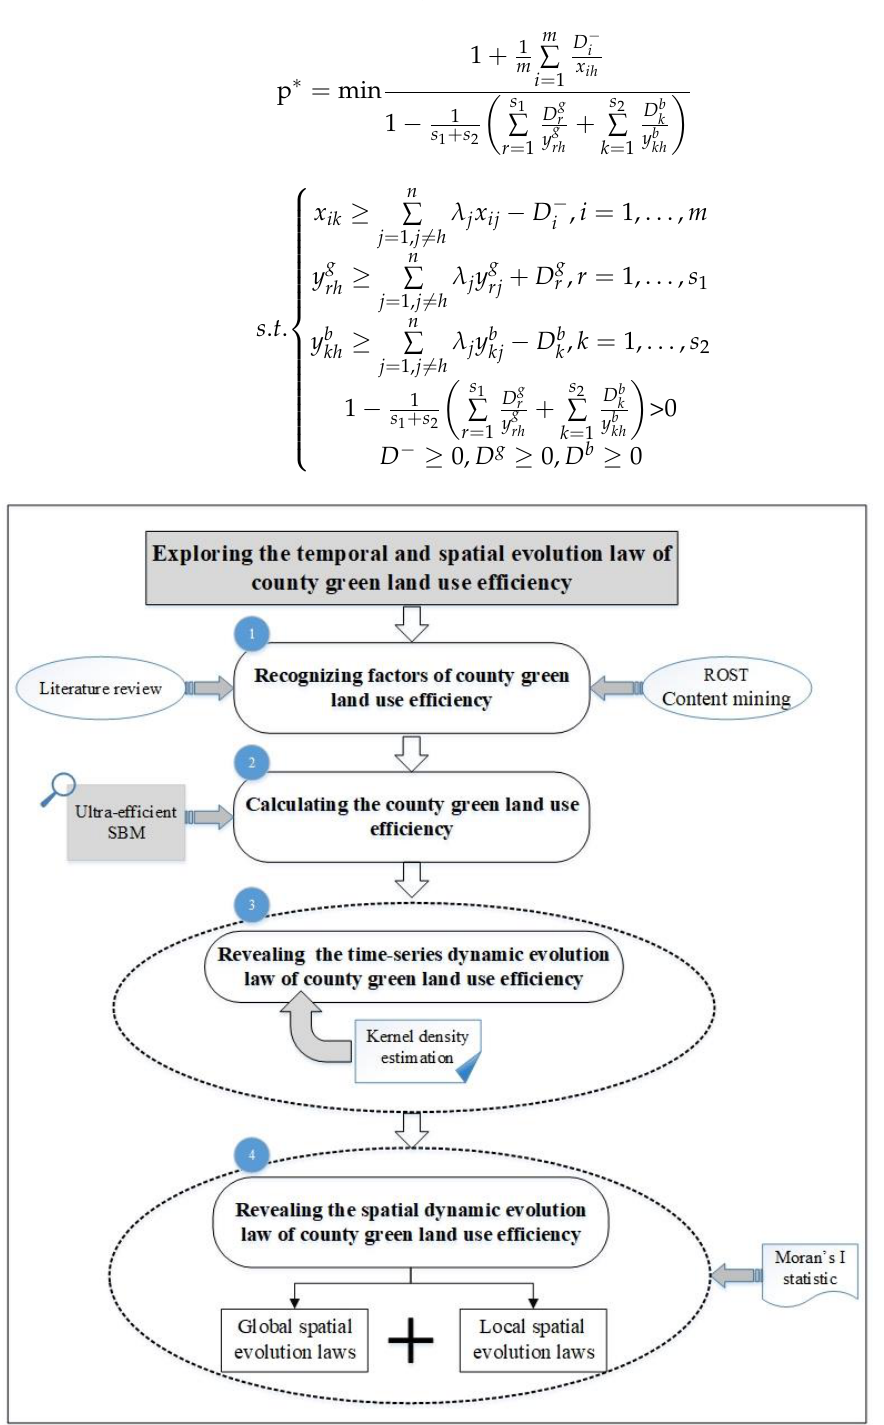
Figure 1. The general framework of this research.